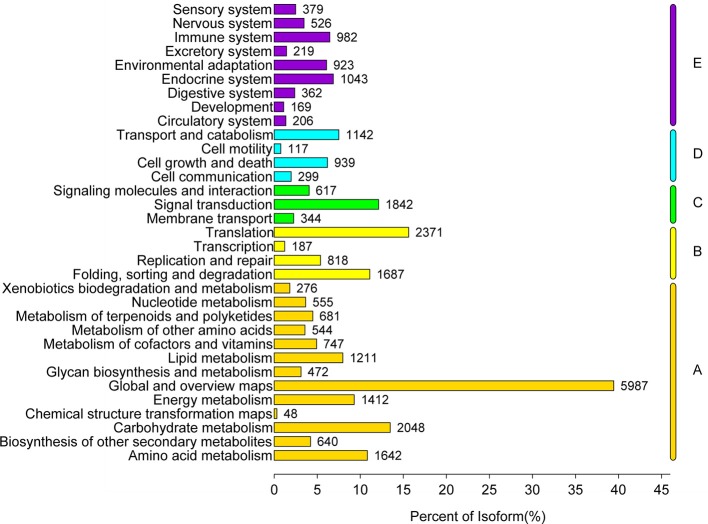
Functional classification and pathway assignment of assembled unigenes by Kyoto Encyclopedia of Genes and Genomes (KEGG). A total of 23,152 unigenes were classified to the five main KEGG metabolic pathways, they are the metabolism (A), genetic information processing (B), environmental information processing (C), cellular processes (D), and organismal systems pathways (E). The y-axis represents the name of KEGG metabolic pathway. The x-axis indicates the number of unigenes annotated to the KEGG metabolic pathway and the ratio of their number to the total number of annotated unigenes.